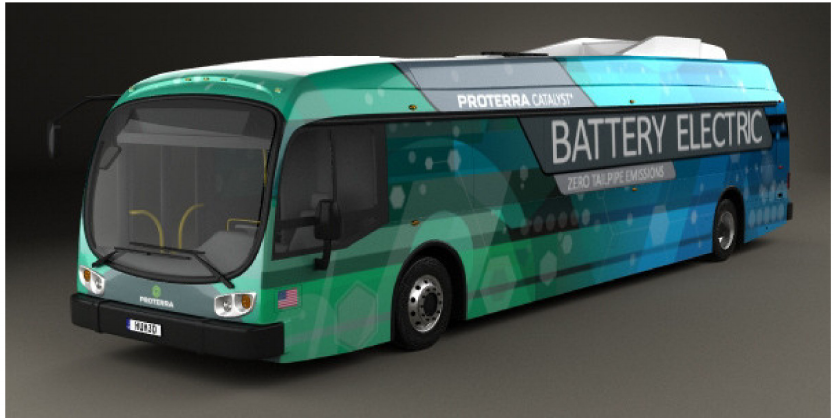
Figure 5. Proterra Catalyst E2